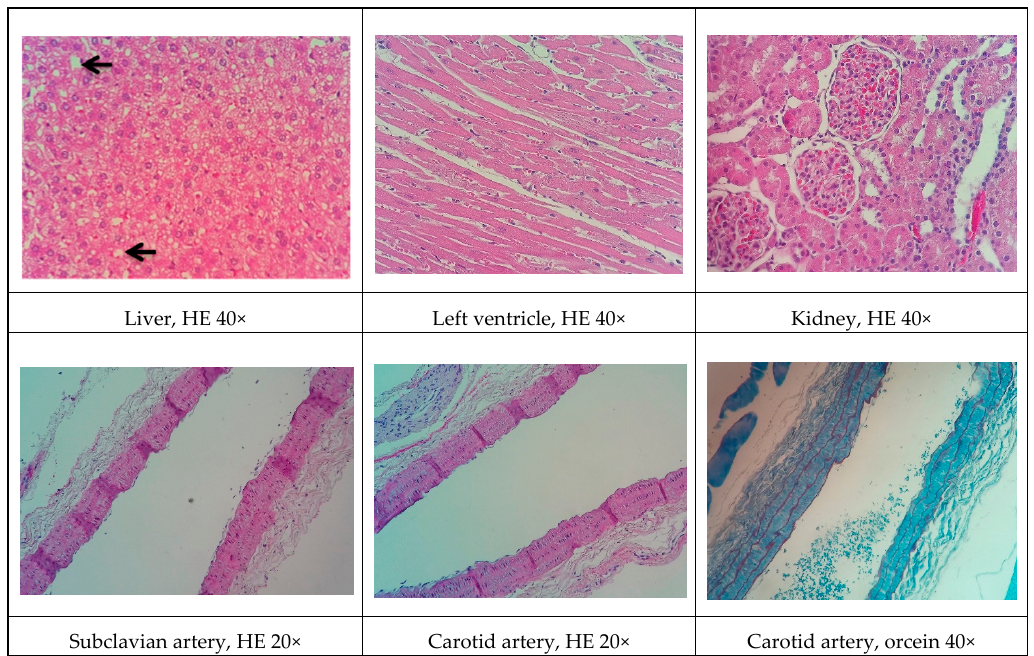
Figure 2. Representative cross-sections of the liver, left ventricle, kidney, and subclavian and carotid arteries in the NOAD group. Black arrows indicate lipid macrovesicles in the liver. HE, hematoxylin-eosin staining; NOAD, normotensive and ovariectomized rats that received the atherogenic diet, methimazole, and cholecalciferol.